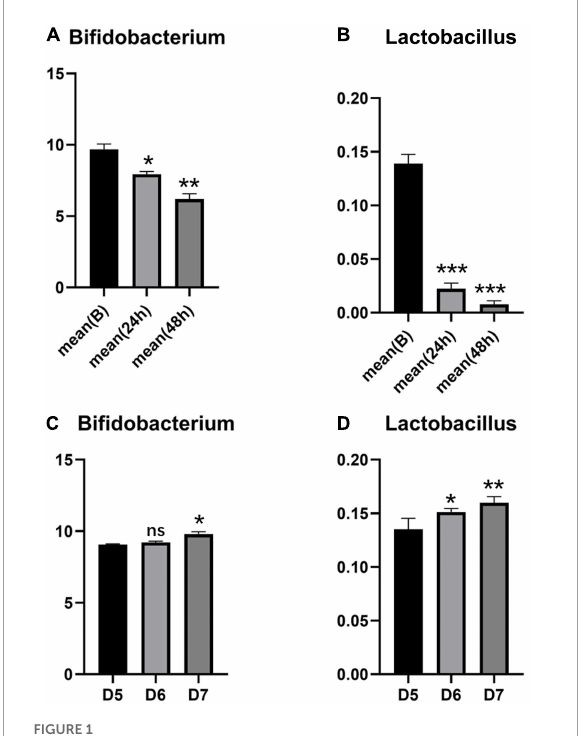
FIGURE1 Changes of Bifidobacterium and Lactobacillus in two groups of neonates. (A,B) Changes of Bifidobacteria and Lactobacillus in children with phototherapy; (C,D) Changes of Bifidobacterium and Lactobacillus of healthy control newborns. Data are represented as means ± SD of three independent experiments. * P < 0.05, ** P < 0.01, and *** P <